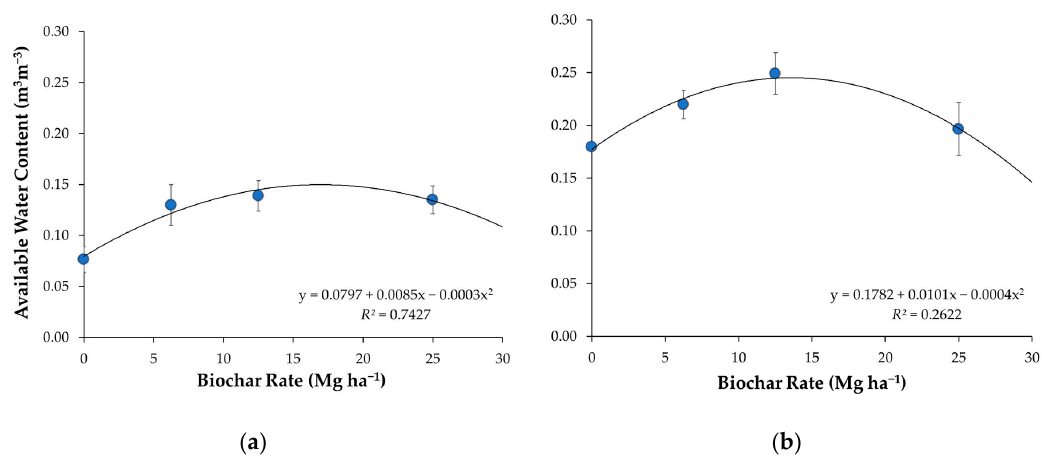
Figure 3. Available water content in the soil for biochar rates (0, 6.25, 12.5 and 25 Mg ha − 1 ) evaluated at ( a ) 50 days and ( b ) 150 days after incorporation in soil. Bars represent the standard error. n = 4.